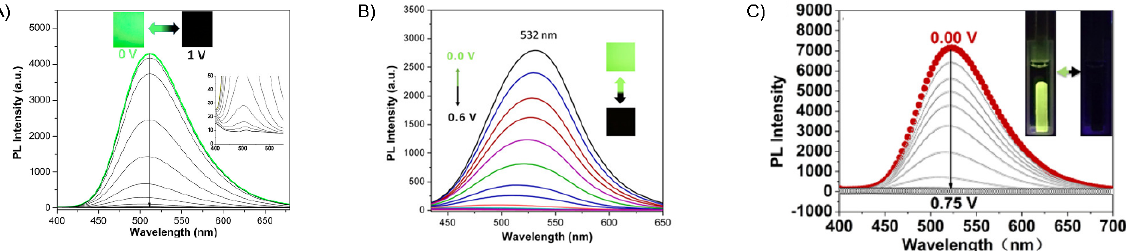
Figure 16. Electrofluorochromism of P10a ( A ), P11a ( B ), and P13a ( C ) in a half ‐ device configuration [144,145,148]. Insets ( A – C ) photographs showing the deactivation/activation of fluorescence with applied potential. ( A ) Reproduced with permission from ref. [144]. Copyright 2018 American Chemical Society. ( B ) Reproduced with permission from ref. [145]. Copyright 2019 American Chemical Society. ( C ) Reproduced with permission from ref. [148]. Copyright 2020 American Chemical Society.